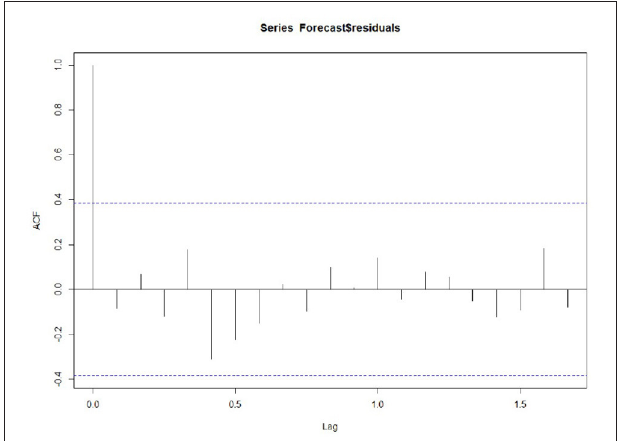
FIGURE 3 | Prediction of patient flow.